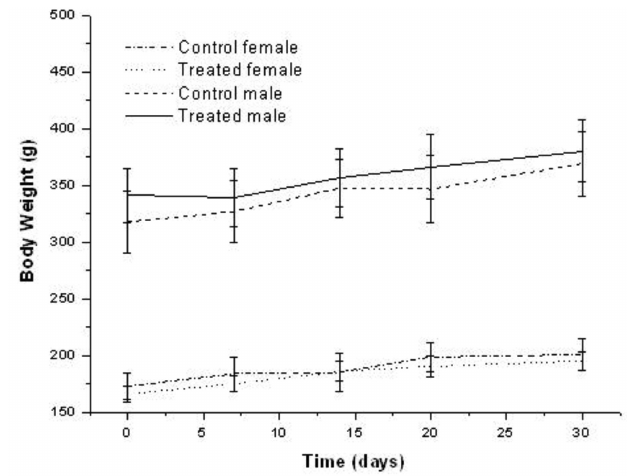
FIGURE 3 - Changes in rat body weight during 30-day atranorin (ATR) treatment (50 mg/kg). Each point represents mean ± standard deviation (SD) of n =